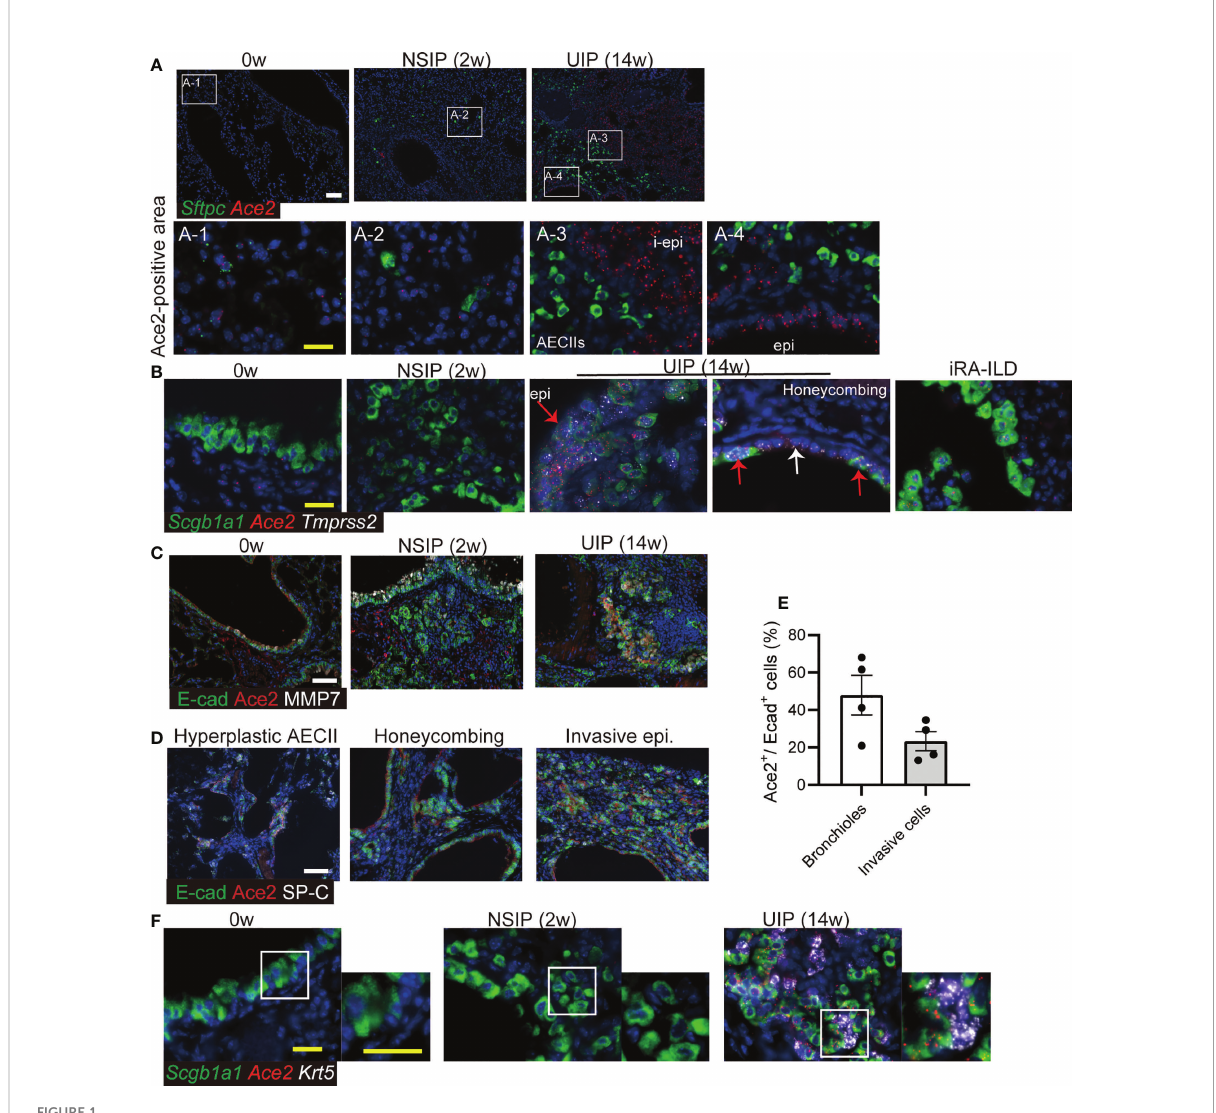
FIGURE 1 Ace2 expresses in AECII and epithelial cells with abnormalities. (A) In situ hybridization of Sftpc (green) and Ace2 (red), (B) Scgb1a1 (green), Ace2 (red), and Tmprss2 (white) in the lungs at week 0, the NSIP (2w), the UIP (14w) stages, and iRA-ILD. Red arrows indicate epithelial cells expressing Scgb1a1 , Ace2 , and Tmprss2 . The white arrow indicates the inner cells of the honeycomb structure that express only Tmprss2 . A-1 to-4 are enlarged images. (C) Immunohistochemical staining for E-cadherin (E-cad, green), ACE2 (red), and MMP7 (white) at week 0, the NSIP, and the UIP stages. (D) Immunohistochemical staining for E-cadherin (green), ACE2 (red), and SP-C (white) in the areas of hyperplastic AECII, honeycombing, and invasive epithelial cells at the UIP stage. (E) Percentage of Ace2 + cells in E-cadherin + bronchioles or invasive cells at the UIP stage. Data are presented as mean ± SE of fi ve images. (F) in situ hybridization of Scgb1a1 (green), Ace2 (red), and Krt5 (white) in the bronchiolar epithelium at week 0, the NSIP, and the UIP stages. Scale bars indicate 50 µm (white) and 20 µm